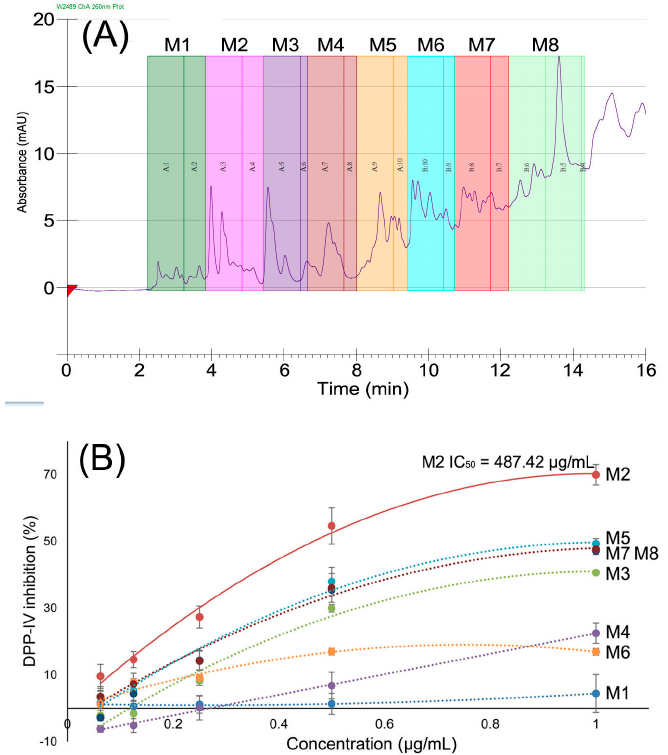
Figure 2. ( A ) RP-HPLC profile of the supernatant of papain-produced RPH; ( B ) DPP-IV inhibitory activities of subfractions from 60% supernatant of RPHs separated by RP-HPLC; M2 showed DPP-IV inhibitory activity of 487.42 μ